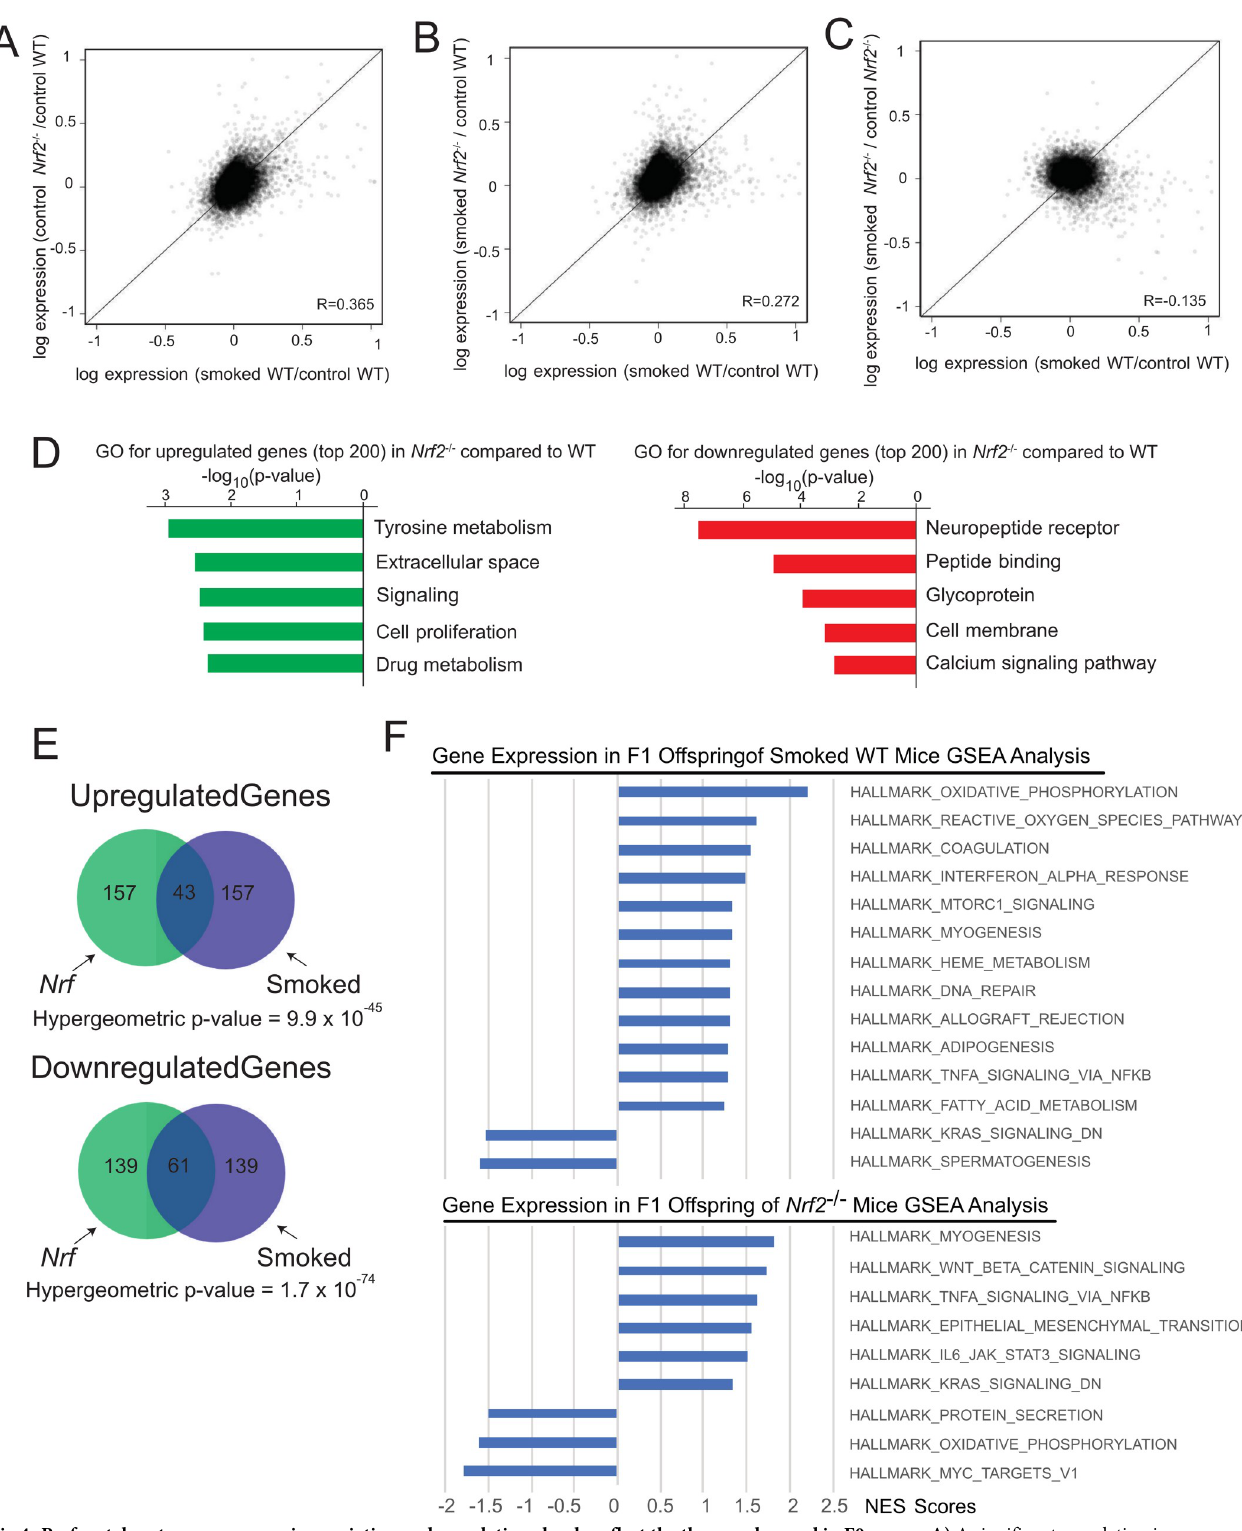
PLOS Genetics | https://doi.org/10.1371/journal.pgen.1008756 June 10,